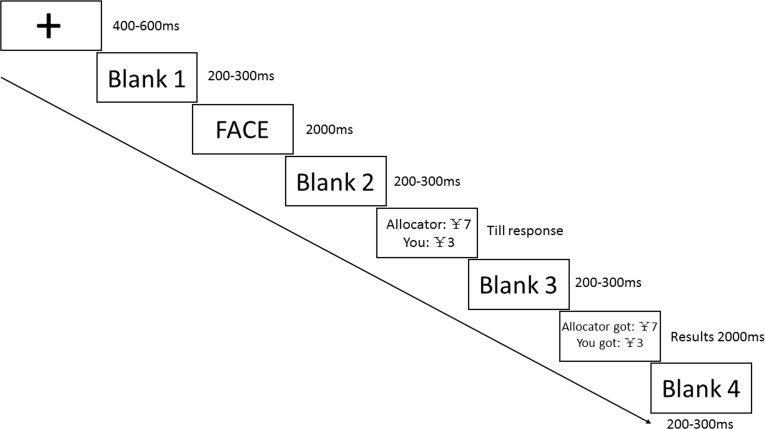
A single trial of the experimental procedure.